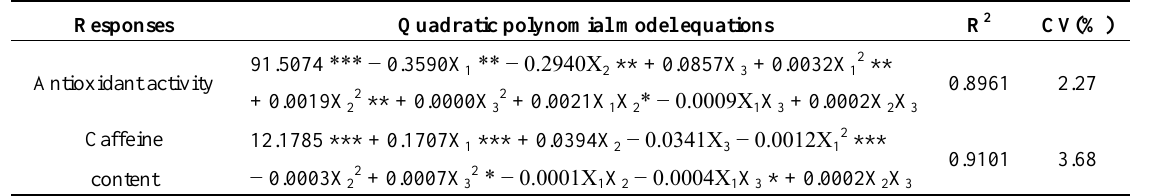
Table 2. Coded and processed variables levels used in experimental design for